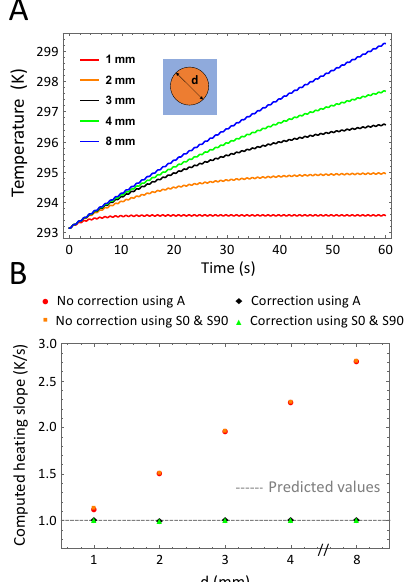
Figure 3. Variations of the cuvette diameter. ( A ): Time-dependent temperature of the sample for different cuvette diameters. For smaller diameters the signal reaches the quasi-steady state faster than for a larger cuvette, for which the signal is still in the thermal relaxation phase after 60 s. ( B ): Computed heating slope for different cuvette diameters. Heating slope values are normalized. As expected, for large cuvettes, a correction of the non-initial heating is required to extract accurate values. SAR calculations using the in-phase and in-quadrature signal or the amplitude signal alone lead to similar